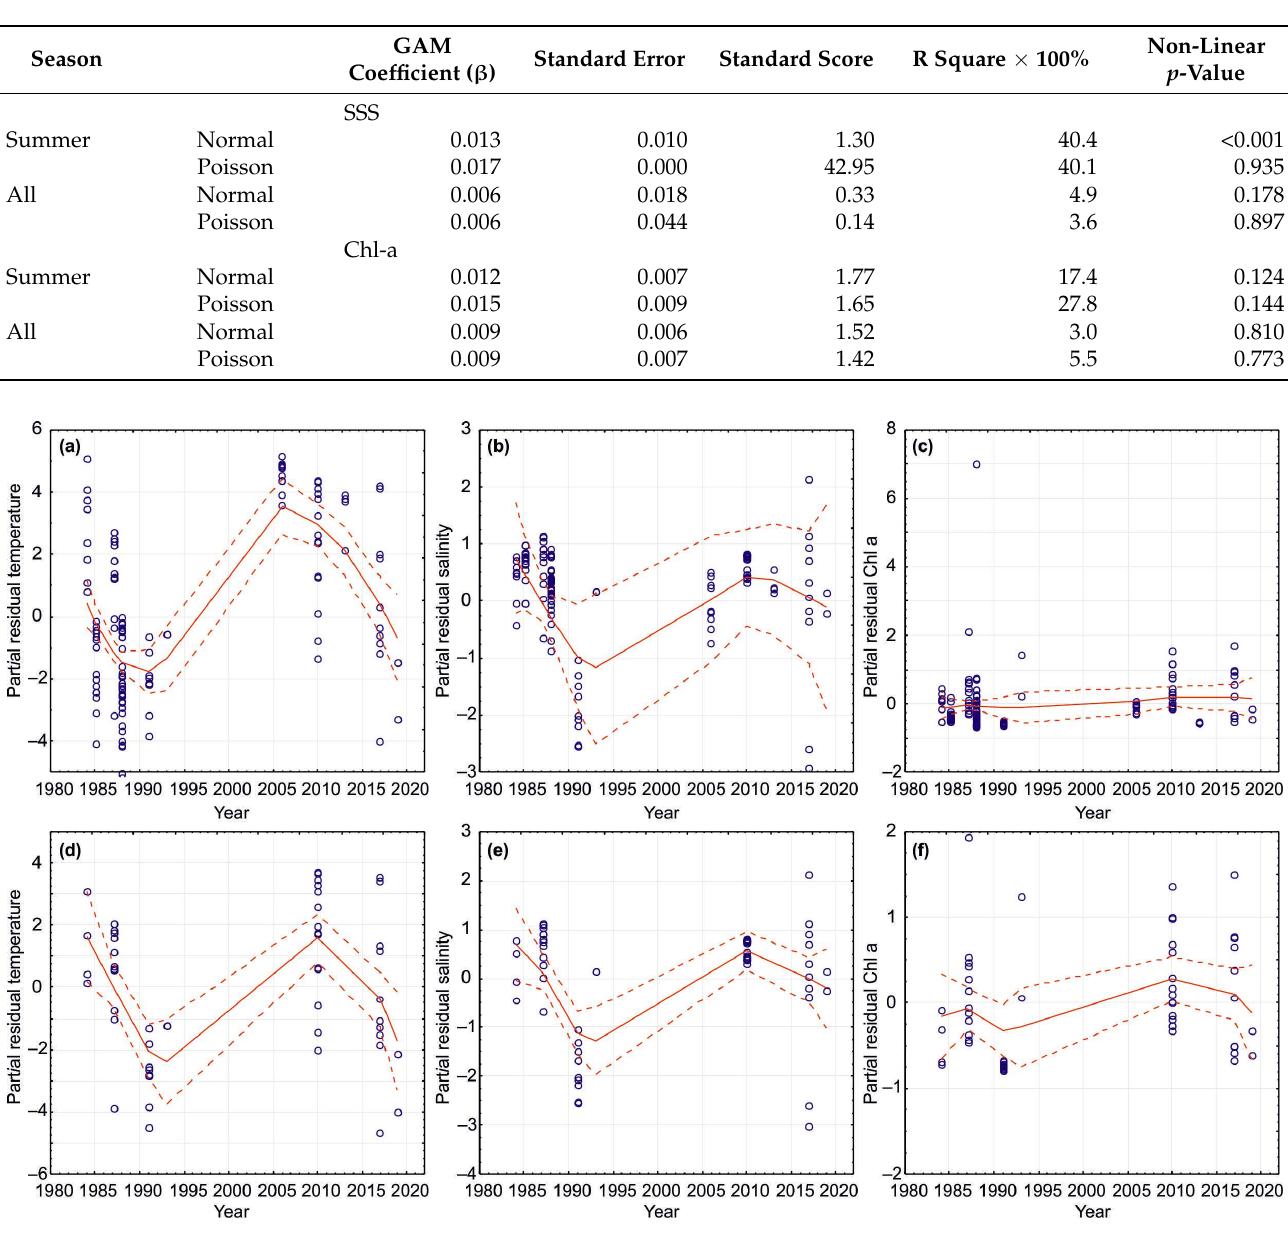
Table 3. Results of linear regression analyses related to SST, SSS, and Chl ‐ a at the Kola Section (Barents Sea, 69°30 ′ –74°30 ′ N, 33°30 ′ N) during the period 1984–2021 with year as an independent variable. Table 4. Cont .